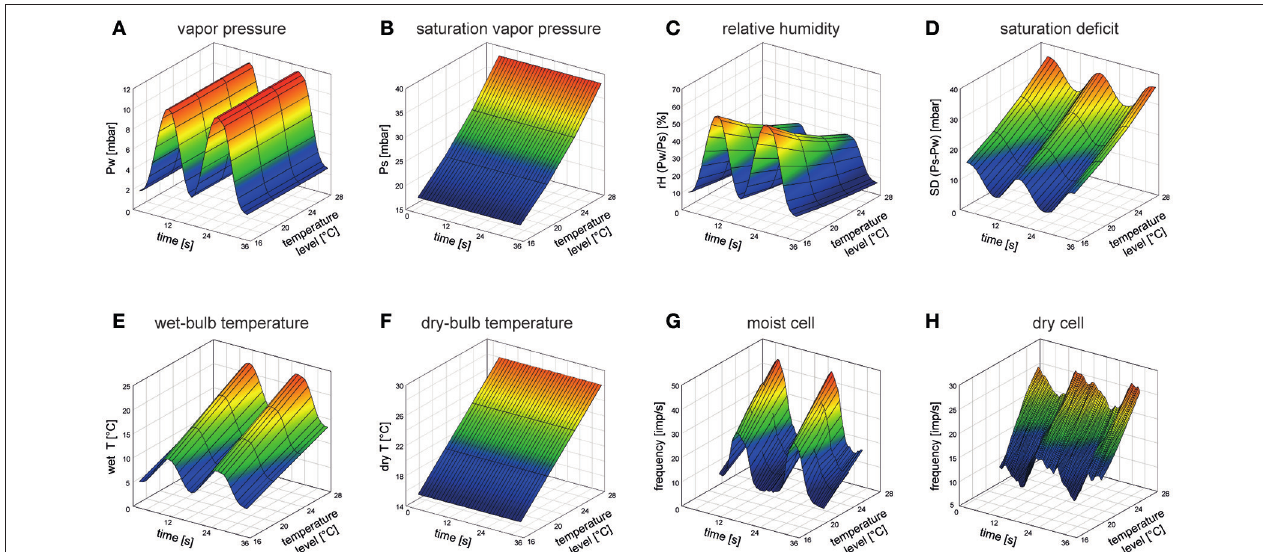
FIGURE 1 | 3D-mesh plots of the effects of air temperature on different ways of expressing humidity and the responses of a moist cell and a dry cell during two periods of slowly oscillating changes in water vapor pressure. (A) Humidity stimulation consisted of two consecutive periods of constant-amplitude oscillations in vapor pressure (0–15 mbar) at four different temperature levels of 21.0, 22.8, 24.7, and 26.8 ◦ C. (B) Saturation vapor pressure at the same temperature levels. Constant-amplitude oscillating change in vapor pressure in A produces, with rising temperature, continuously deceasing oscillations in relative humidity (C) , but continuously increasing oscillations in both saturation deficit (D) and wet-bulb temperature (E) . Dry-bulb temperature as a function of air temperature (F) . (G,H) Impulse frequency of a moist cell and a dry cell recorded simultaneously from the same sensillum on the cockroach’s antenna during oscillations in vapor pressure at the different temperature levels (21.0, 22.8, 24.7, 26.8 ◦ C) illustrated in (A) . With rising temperature, the oscillations in impulse frequency of the moist and dry cells shift upwards on the frequency scale. Impulse frequency ( F , impulses/s) was calculated from running averages of three consecutive 0.5-s intervals ( Tichy and Kallina, 2013). Water vapor density of the stimulating air stream (flow rate, 2.5 m/s) was measured at a rate of 100 Hz by an UV-absorption hygrometer (K 20, Campbell Scientific) and air temperature (dry-bulb temperature, dry T ) was measured within ± 0.03 ◦ C by a small thermistor (250 × 400 µ m; Fenwall Electronics, BC 32 L1). Based on the digitized signals of the hygrometer and the thermistor, the vapor pressure ( Pw ) and the relative humidity ( rH ) were monitored offline. The saturation water vapor ( Ps ), the saturation deficit ( SD ) and the wet-bulb temperature ( wet T ) were calculated using the Vaisala Humidity Calculator, a web-based software tool.